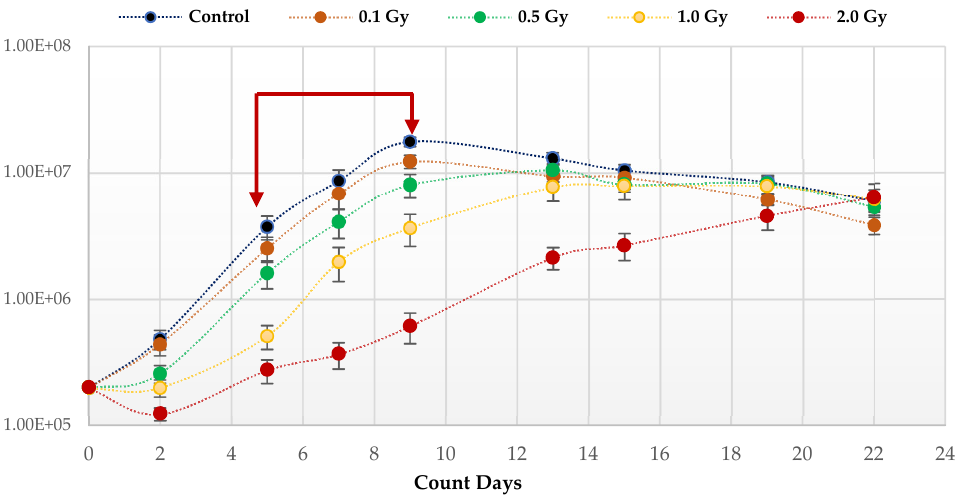
Figure 1. Proliferative capability of HSPCs following IR exposure under low (3%) O 2 state. HSPCs (2 × 10 5 cells/well, x-irradiated (0–2 Gy)) were incubated in 3% O 2 and regular cell counts carried out to day 22 ( N = 3/dose, 3 wells/dose/experiment. Error bars: ± SEM). Two-way ANOVA and Dunnett’s multiple comparison test compared IR- and non-IR exposed HSPCs (0.1 Gy p < 0.001; 0.5 Gy p < 0.001; 1.0 Gy p < 0.0001; 2.0 Gy p < 0.0001). Inter-dose comparisons showed significant difference in all scenarios (student t-test p < 0.05, p < 0.005). Red arrows indicate exponential growth phase (days 5–9). Time and dose showed statistical significance, but subject did